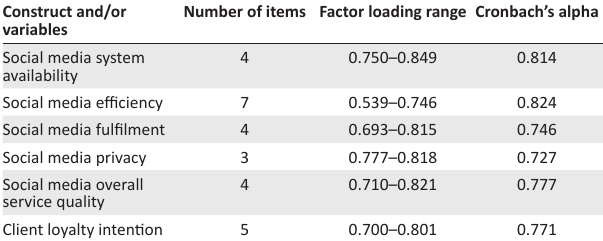
TABLE 1: Reliability and validity